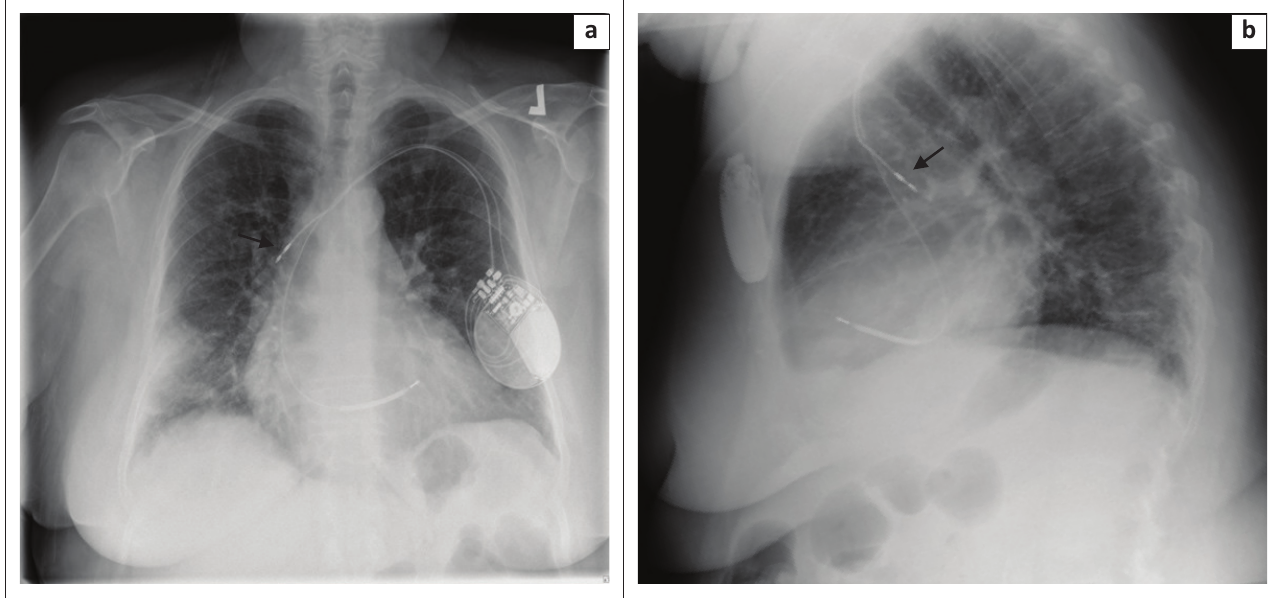
FIGURE 8: Posterior–anterior (a) and lateral (b) chest radiograph views showing a dual-lead implantable cardioverter defibrillator with a single right ventricular shock coil. Note its right atrial lead (arrow) malpositioned in the superior vena